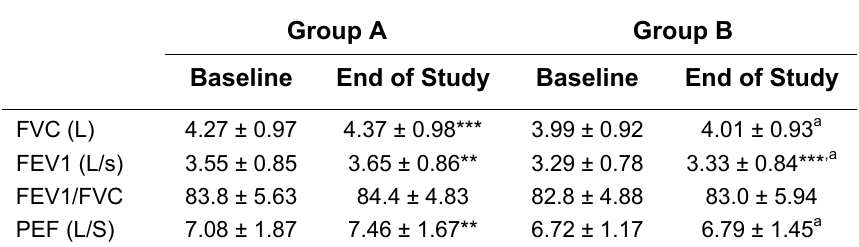
Lung Function, Initially and at the End of the Study